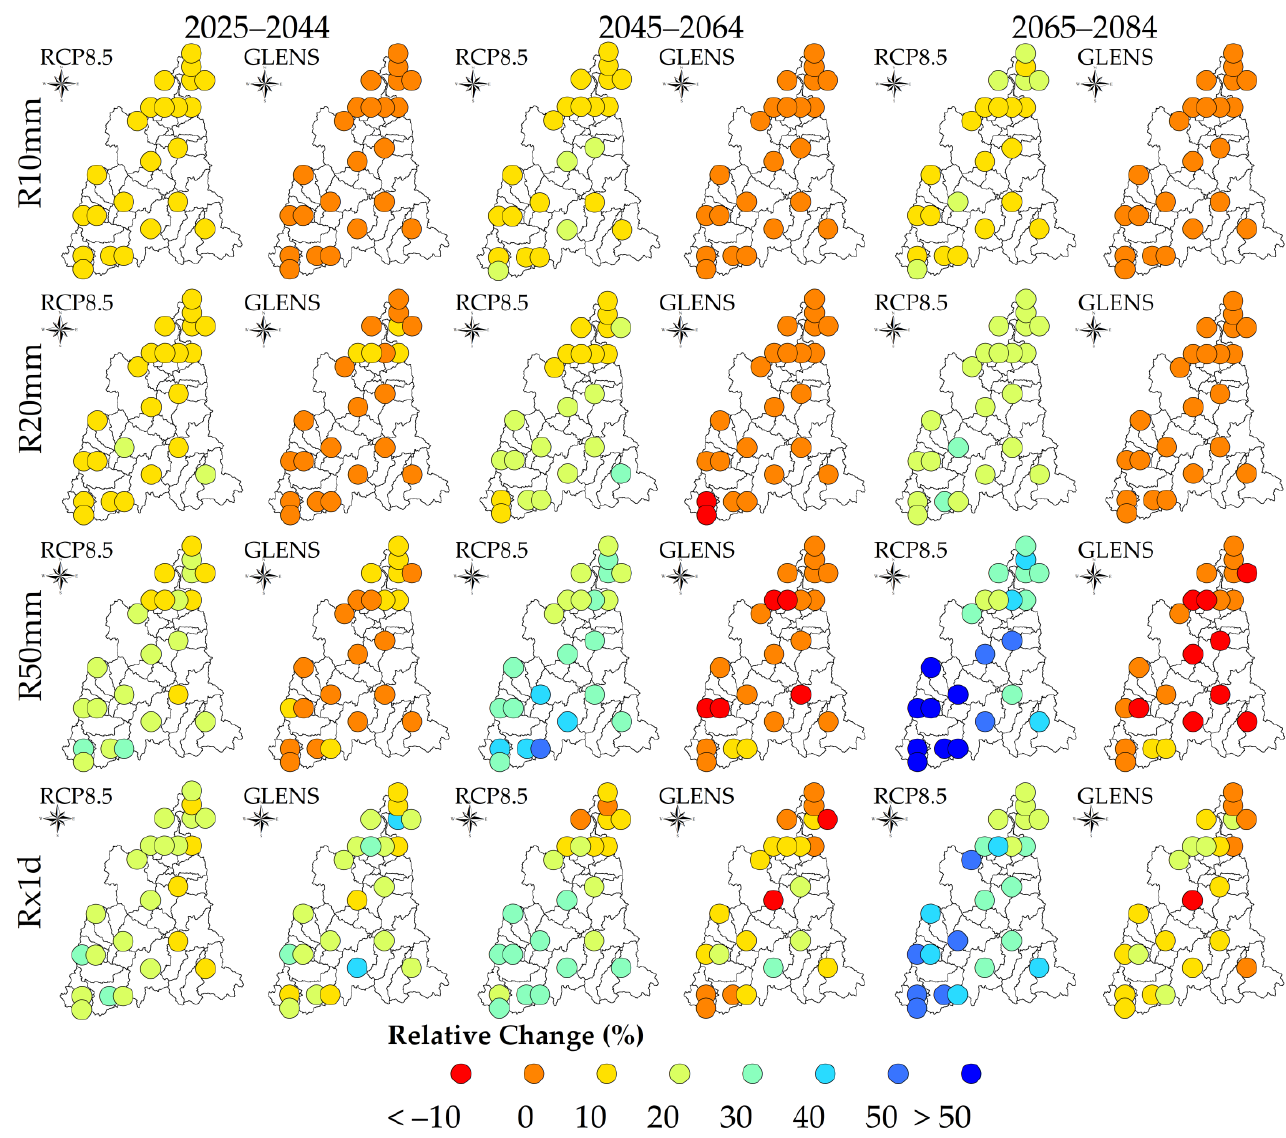
Figure 6. Relative changes in the R10 mm, R20 mm, R50 mm and Rx1d indices under the RCP8.5 and GLENS simulations across the stations during the 2025 – 2044, 2045 – 2064 and 2065 – 2084 periods.